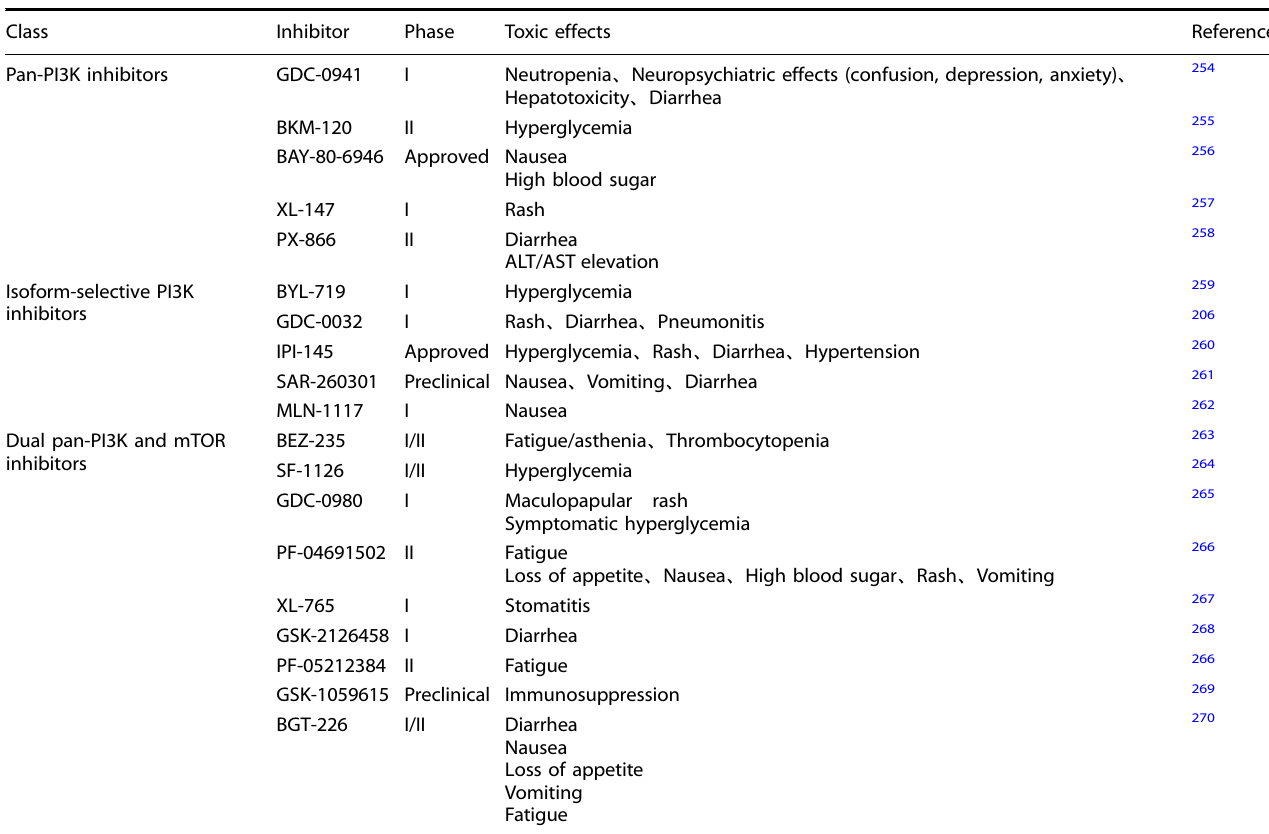
Table 2. Novel agents targeting PI3K signaling in cancer